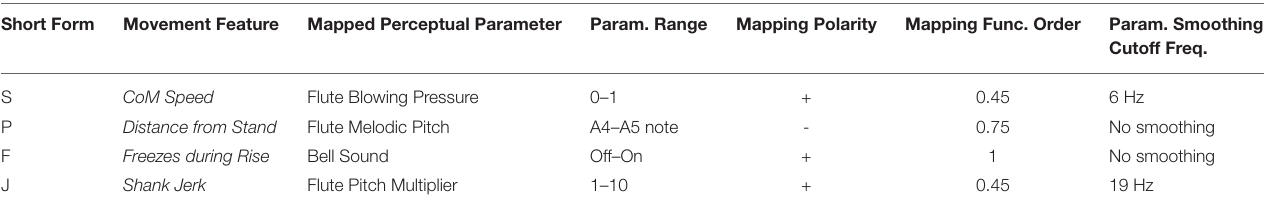
TABLE 2 | A summary of mapping